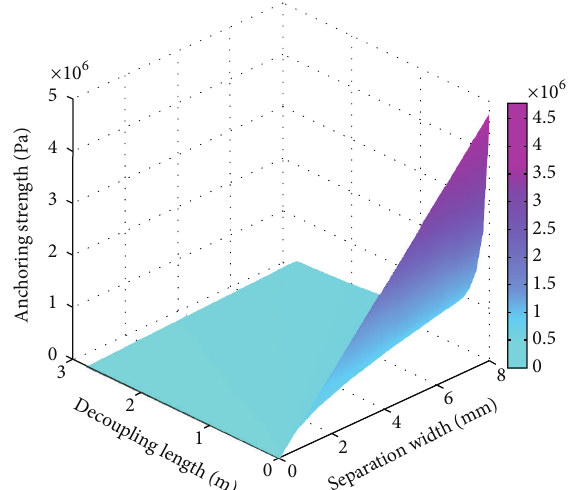
Figure 10: Relationship of the bolt support strength versus separa- tion width and the bolt support strength versus decoupling length (the separation is located near the loading